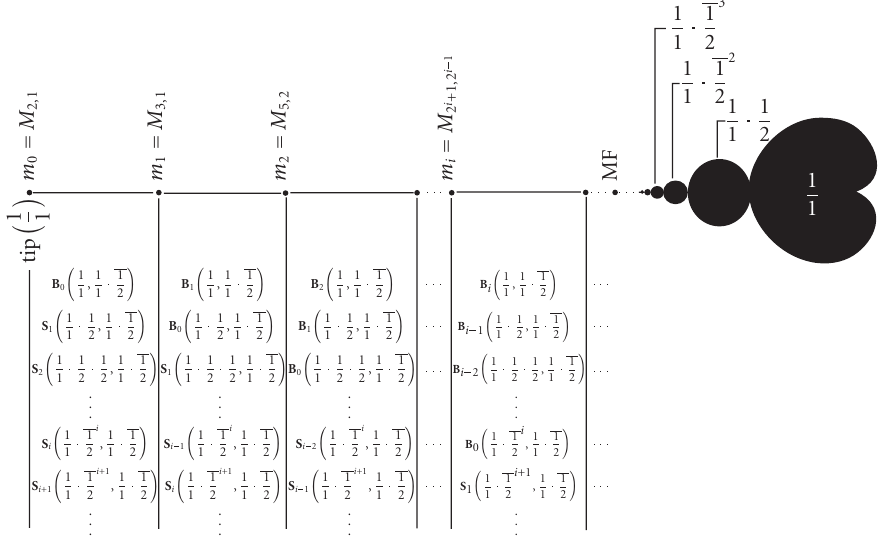
Figure 3.1. Sketch of the 1D route in a 2D representation in order to see it. The upper part shows the periodic and chaotic routes. The lower part shows a table with di ff erent names of each chaotic band.